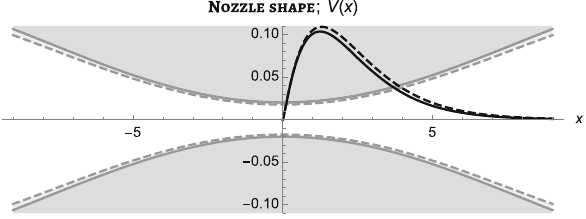
Fig. 1 The nozzle profile for s = (cid:20) = 0. The gray filled area , limited by the continuous ( dashed ) line denotes the de Laval nozzle in the Schwarzschild, GR σ → ∞ , limit (in the minimal geometric deformation of the de Laval nozzle). The black lines represent V ( x ) for the GR limit ( continuous line ) and its minimal geometric deformation ( dashed line )